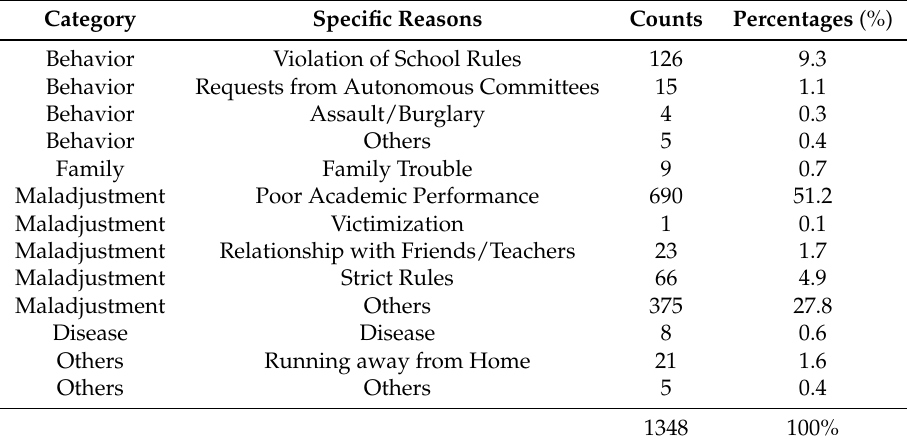
Table 4. 13 reasons for the school register changes considered as